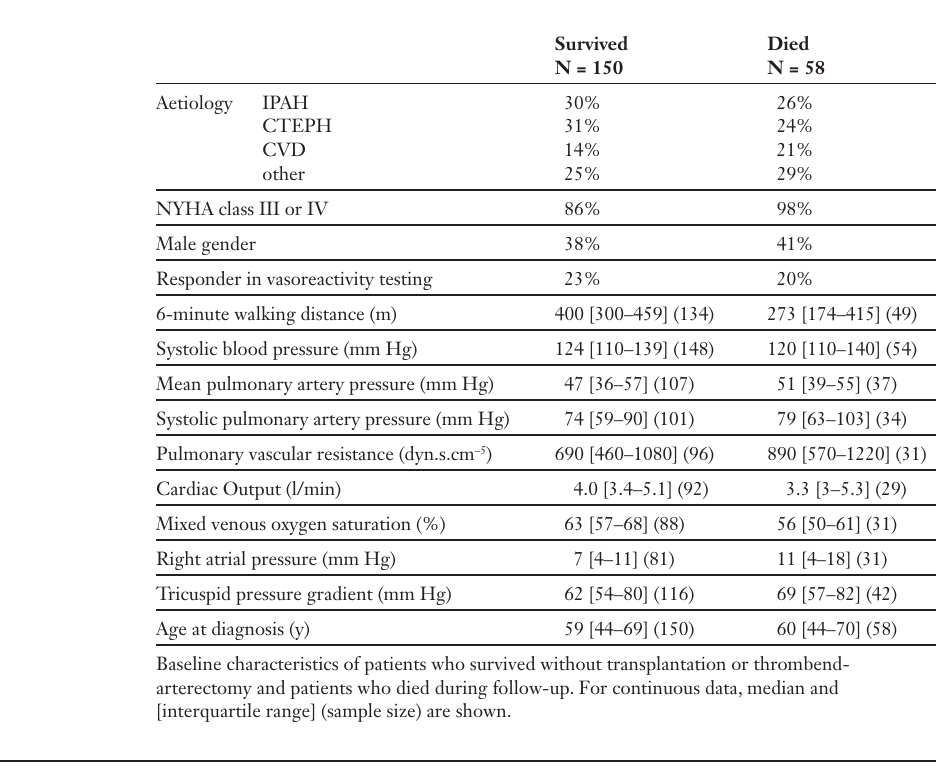
Survival as a function of prognostically im- portant baseline pa-